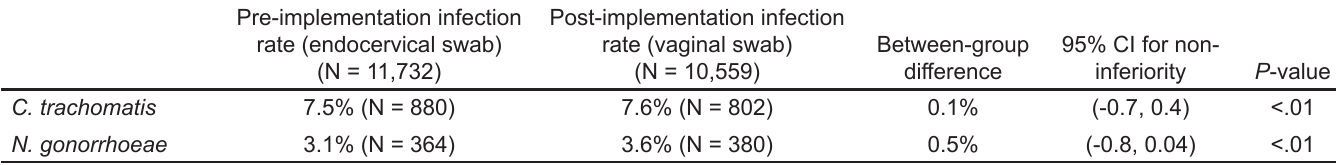
Table. Detection rates for Chlamydia trachomatis and Neisseria gonorrhoeae infection in women before and after implementation of a testing program for sexually transmitted infections, using endocervical swabs vs vaginal swabs (N = 22,291).